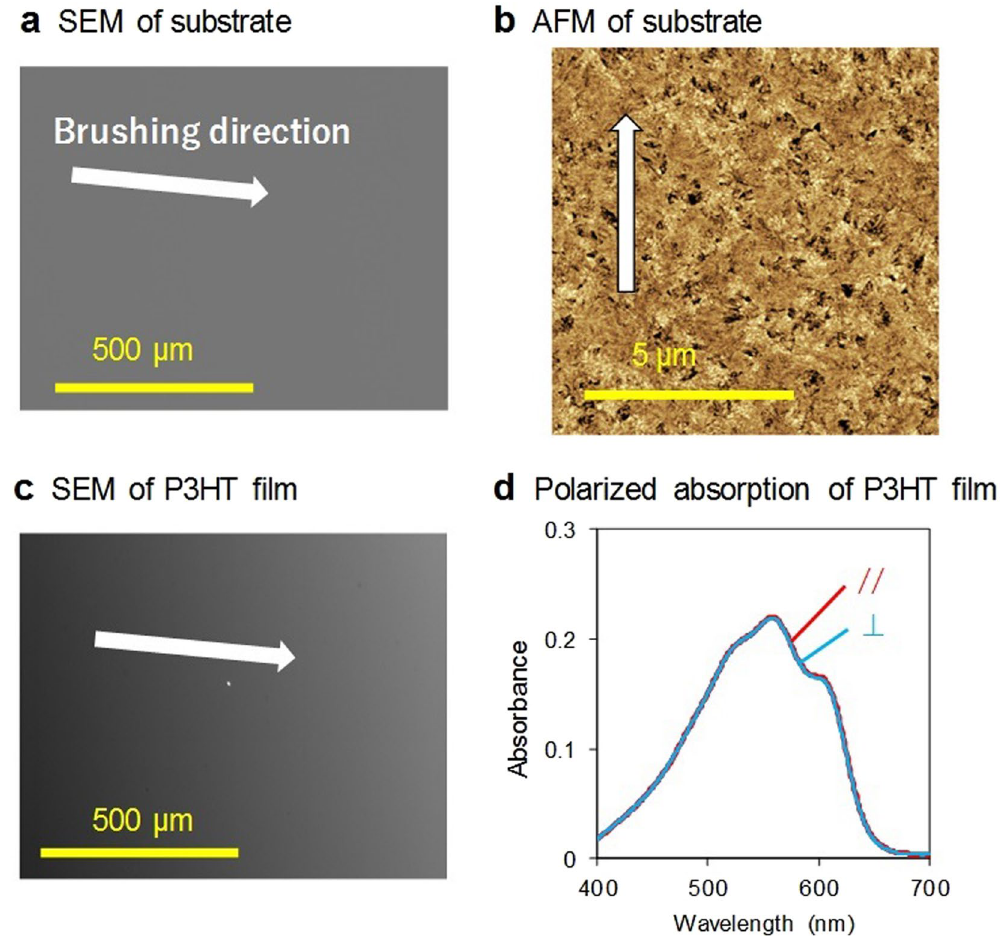
Figure 6. ( a ) SEM and ( b ) AFM images of the substrate washed after brushing. The white arrow indicates the brushing direction. ( c ) SEM image and ( d ) polarized absorption spectra of P3HT film prepared on the substrate washed after brushing. All results showed no anisotropic